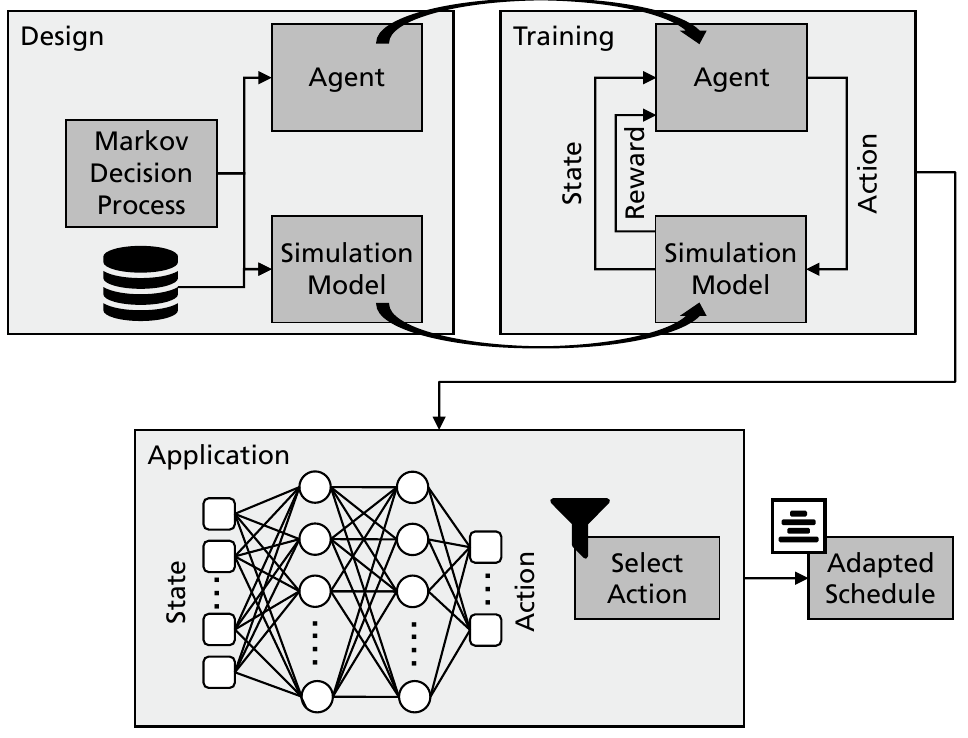
Figure 6. Reinforcement learning-based controlling element for an adaptive control loop for an integrated supply